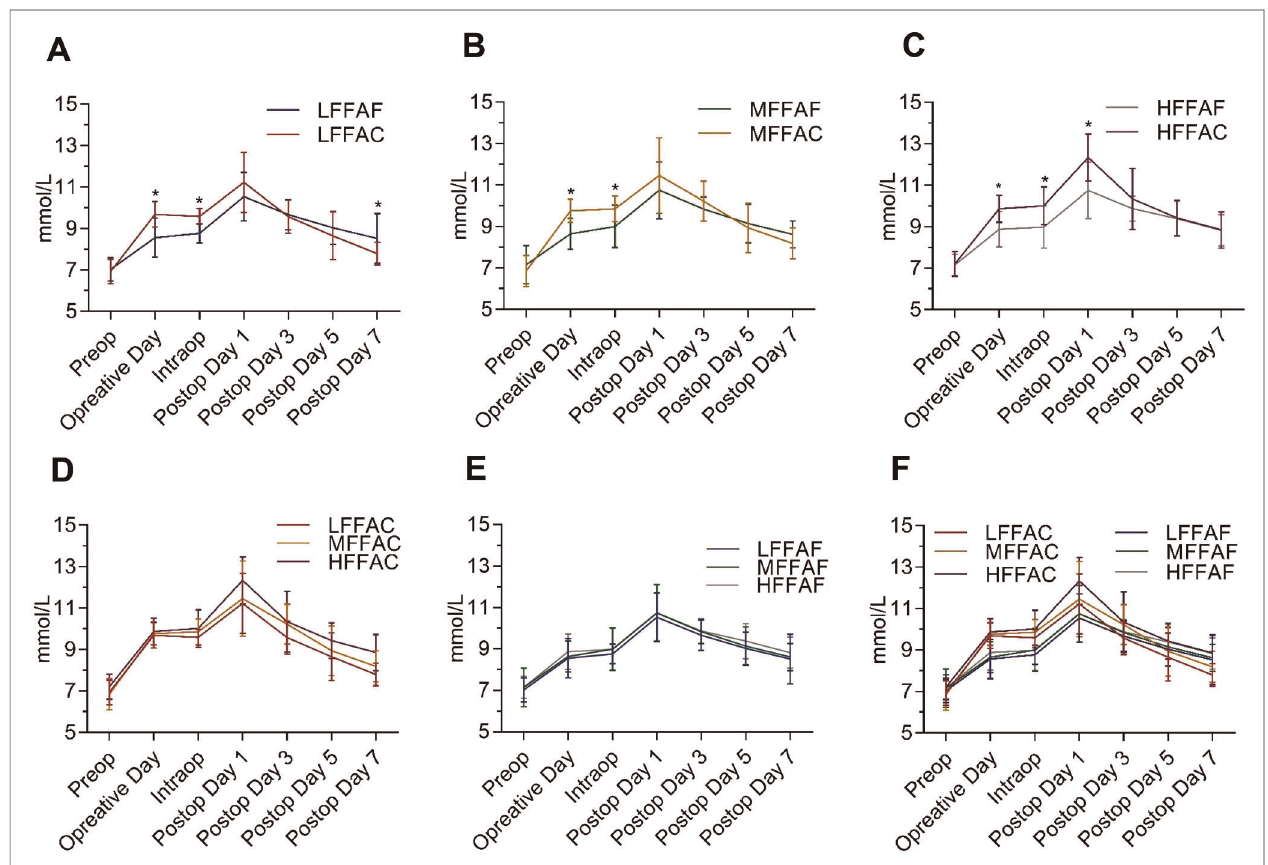
FIGURE 1 | Perioperative glycaemic control timeline in each indicated group during the perioperative period. ( A ) Comparison of perioperative blood glucose between the low FFA carbohydrate group (LFFAC group) and the low FFA fasting water group (LFFAF group). ( B ) Comparison of perioperative blood glucose between the medium FFA carbohydrate group (MFFAC group) and the medium FFA fasting water group (MFFAF group). ( C ) Comparison of perioperative blood glucose between the high FFA carbohydrate group and the high FFA fasting water group. ( D , E )Comparison of perioperative blood glucose in patients with different FFA values under POC or fasting water conditions. ( F )Comparison of perioperative blood glucose among the 6 groups. *, represents a signi fi cant difference ( p